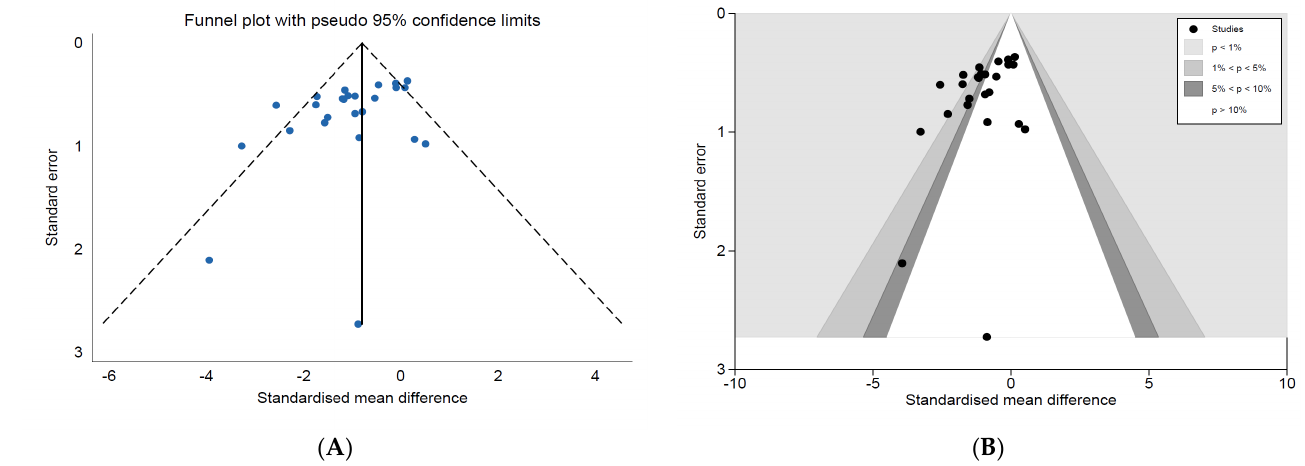
Figure 4. ( A ) Standard and ( B ) contour-enhanced funnel plots for comparators investigating the effects of vaccinating meat chickens against Campylobacter . Note: ( A ) Lower and upper 95% confidence intervals are represented by the dashed lines and the pooled SMD represented by the vertical solid line; ( B ) white/no shading: p > 10%, dark grey: 5% < p < 10%, grey: 1% < p < 5%, light grey: p < 1% .